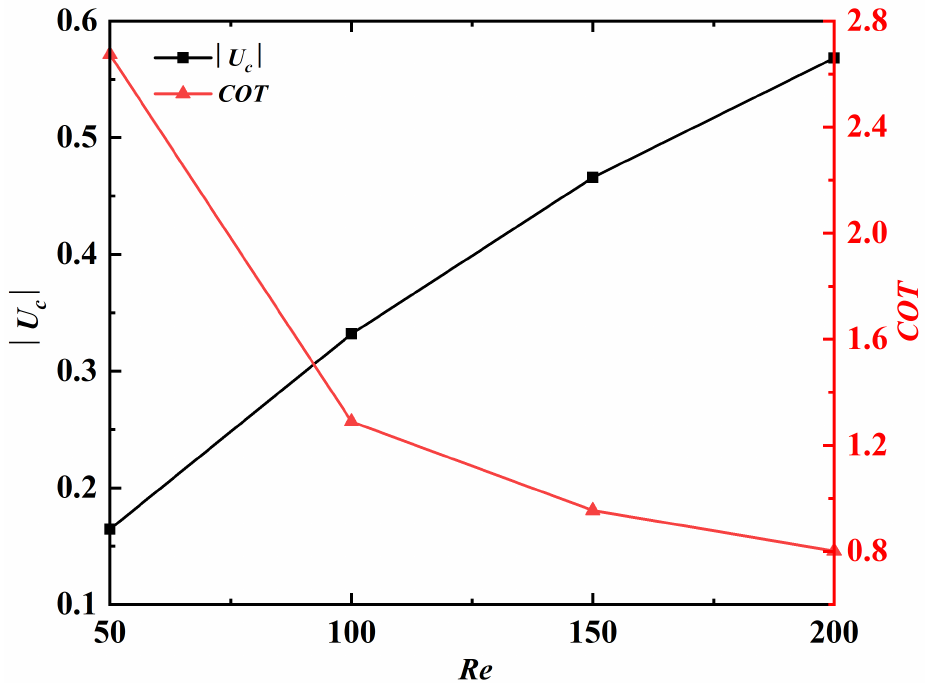
Figure 11. U c and COT as a function of Re . The absolute value of U c is plotted since the propulsor is swimming in the negative x